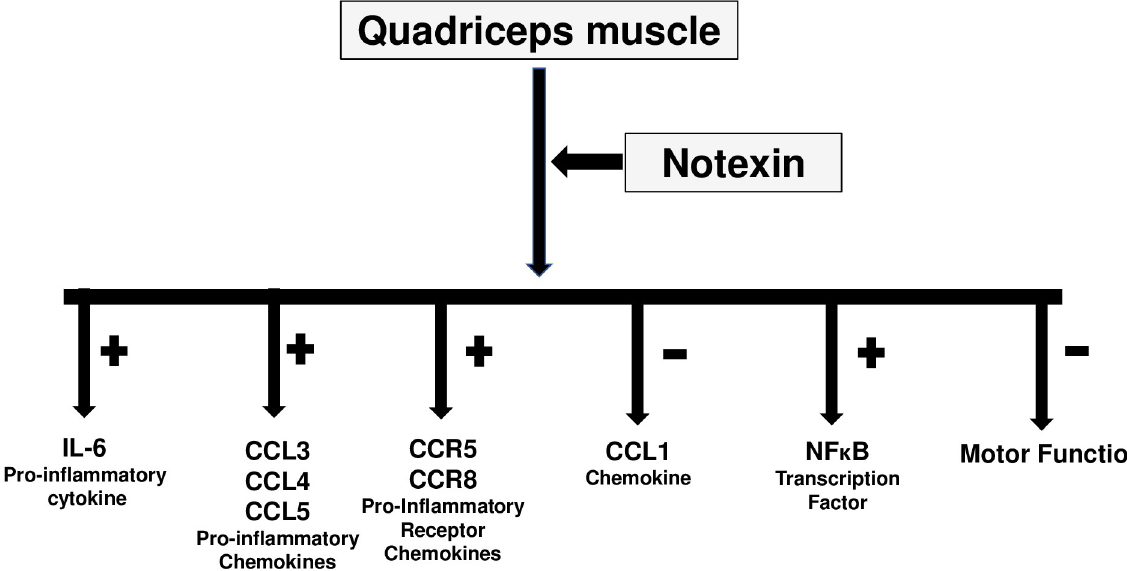
Fig 7. Notexin action on quadriceps muscle of rat. Increase in proinflammatory cytokines, chemokines, chemokines receptors and NF κ B protein with decrease in CCL1 chemokine and motor function are indicated.